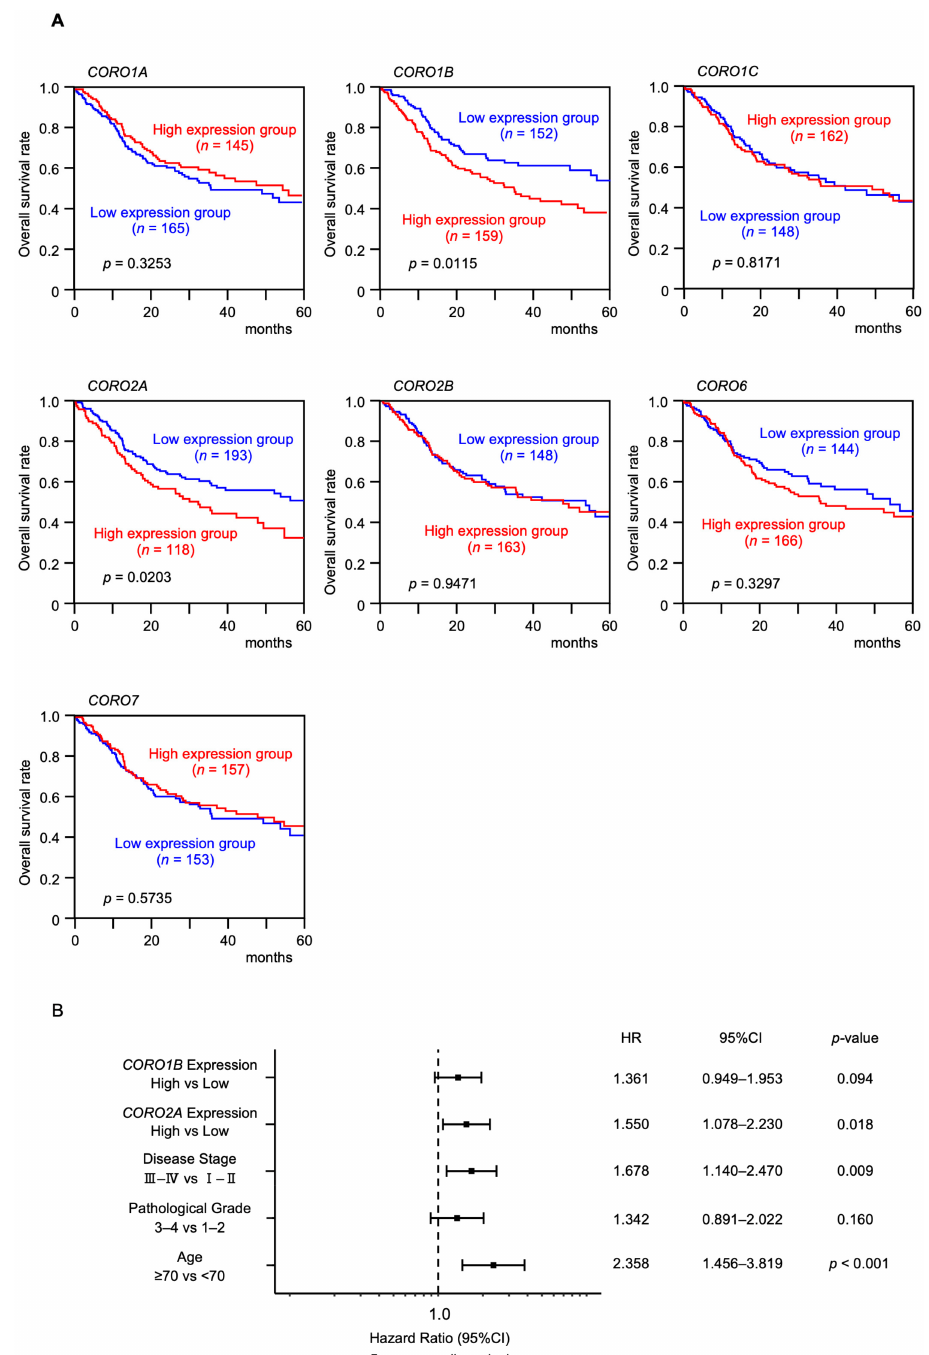
Figure 2. Clinical significance of all members of the coronin family by TCGA-OSCC analysis. ( A ) Kaplan–Meier survival curve analyses of patients with OSCC using data from The Cancer Genome Atlas (TCGA) database. Patients were divided into high and low expression groups according to miRNA expression (based upon median expression). The red line shows the high expression group, and the blue line shows the low expression group. ( B ) Forest plot presenting the results of a multivariate Cox regression analysis of the prognostic value of CORO1B and CORO2A identified in an OSCC dataset from TCGA (HR: hazard ratio, CI: confidence interval). The expression level of CORO2A was determined to be independent prognostic factors in terms of the 5-year overall survival rate after adjustments for tumor stage, age, and pathological grade ( p <